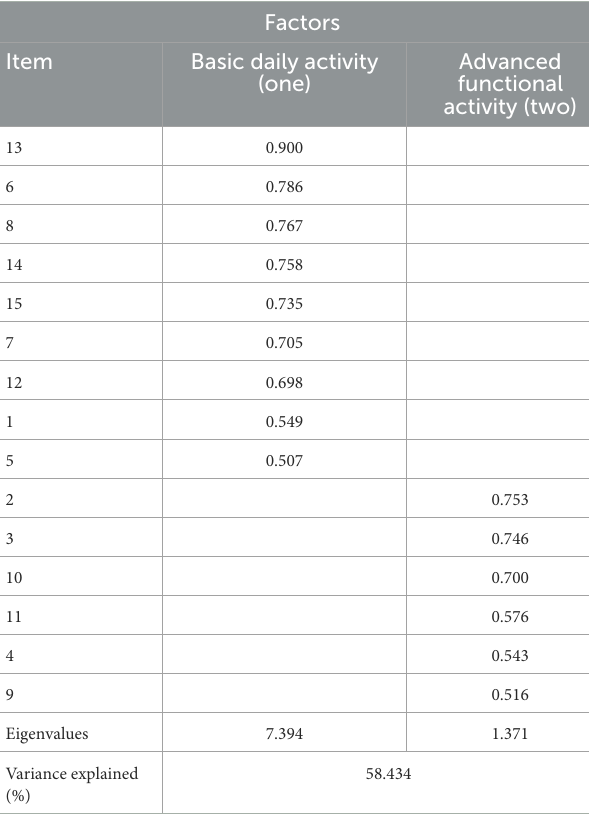
TABLE 5 Correlations of performance between C-UEFI and stroke-specific impairments in people with chronic stroke ( N = 101).